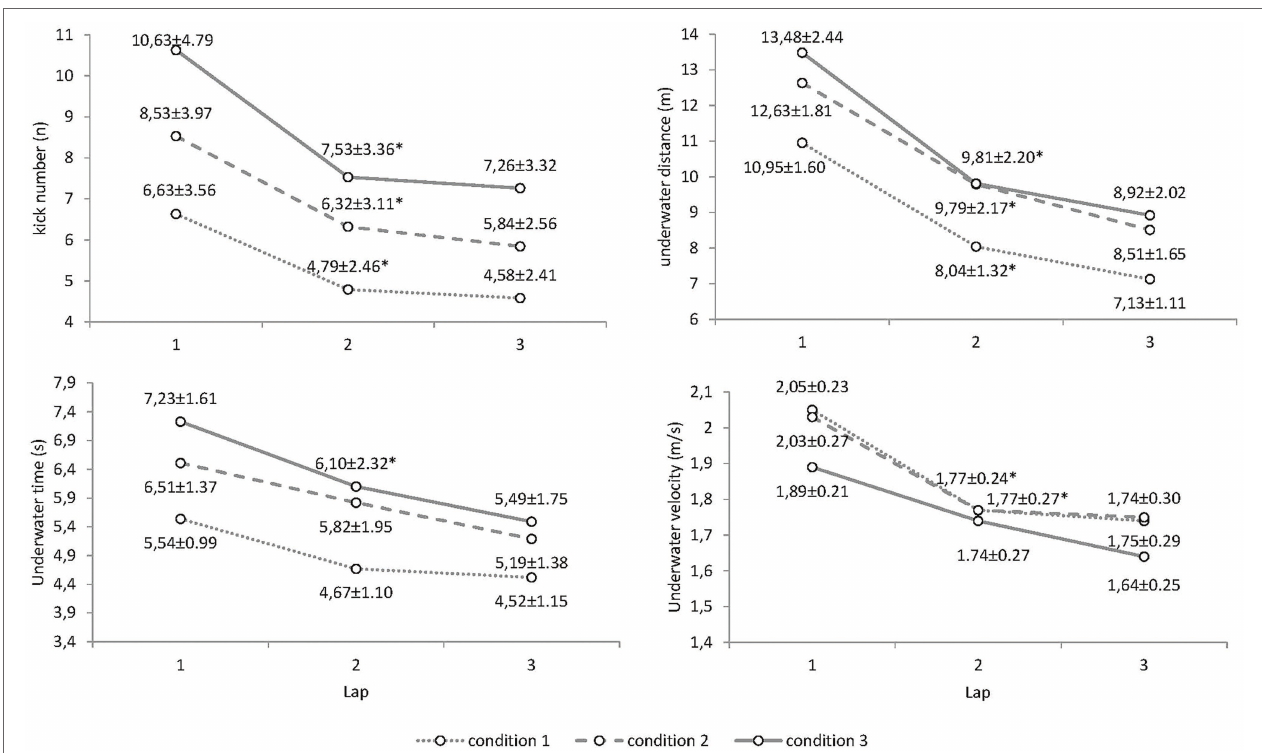
FIGURE 3 | Evolution of the underwater parameters of competitive swimmers in different underwater swimming